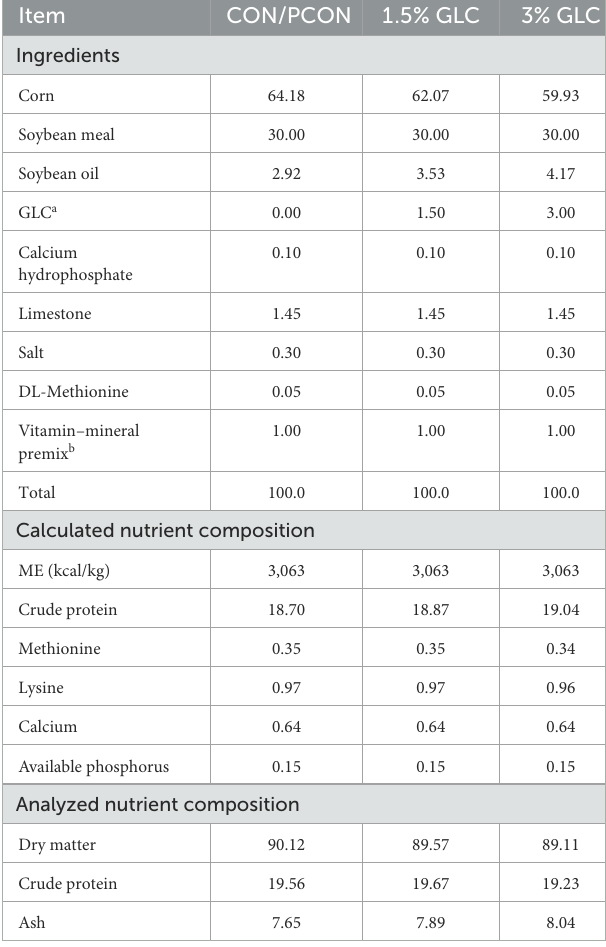
TABLE 2 Composition and nutrient levels of the experimental diets (%, as-fed